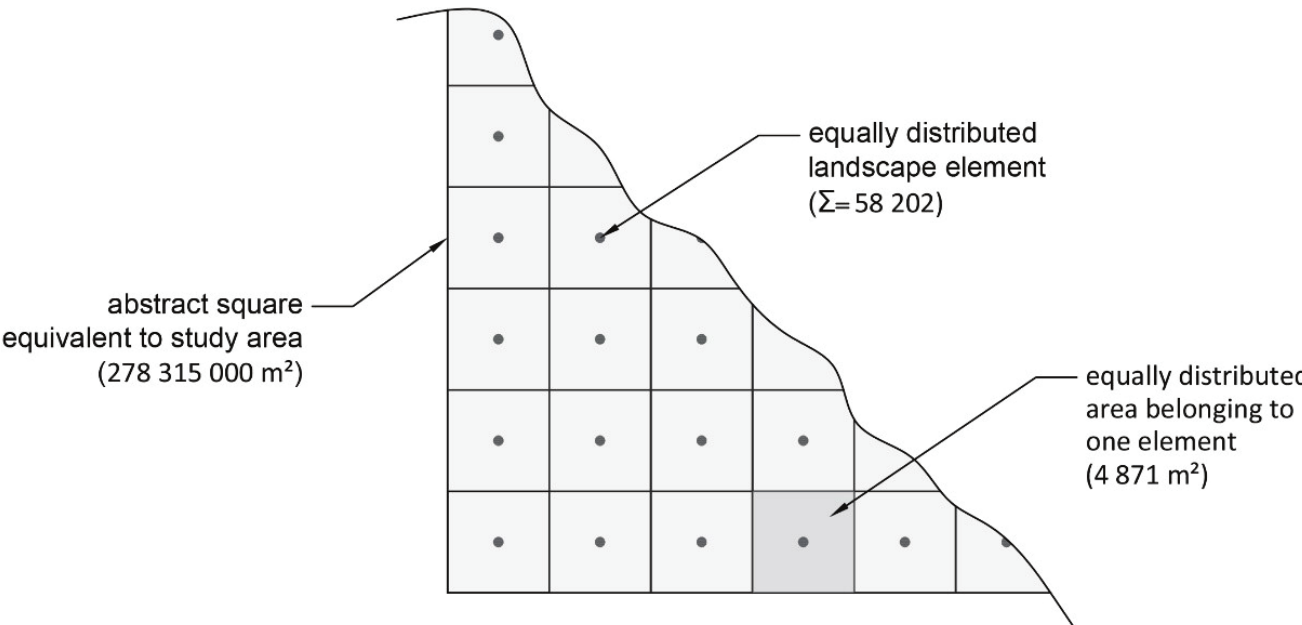
Figure 3 Graph showing the rationale behind the calculation of the equally distributed area of each point